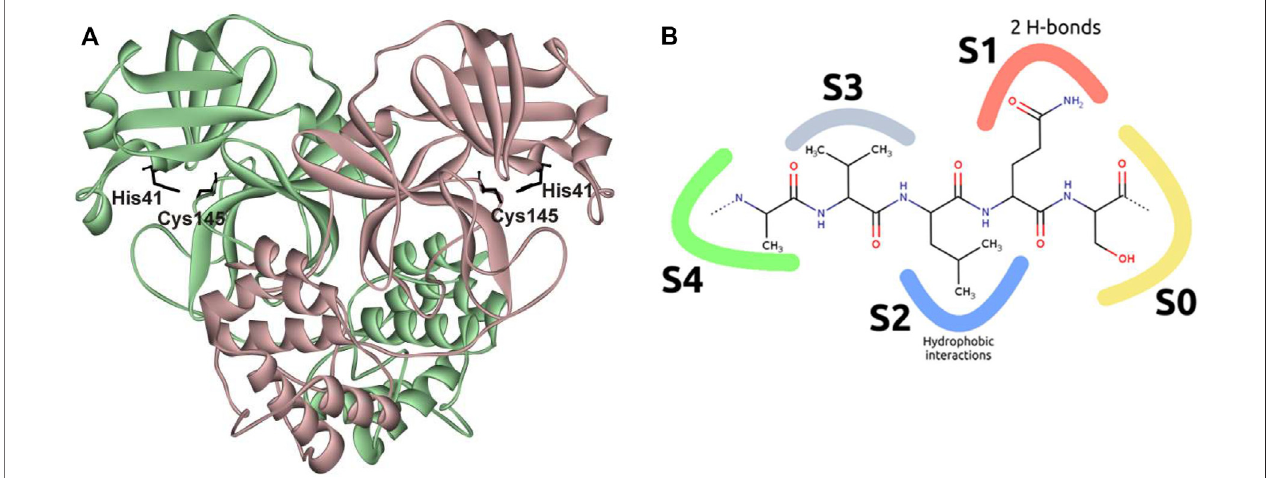
FIGURE1| StructureofSARS-CoV-2M pro . (A) OverviewofthestructureofanM pro complexwithPF-00835231(ProteinDataBank[PDB]ID6XHM(Hoffmanetal., 2020); ligand not shown); (B) schematic representation of interactions of the active site with the substrate. The S0 subpocket is formed mostly by Asn142, Ser144, Cys145,andLeu27;S1includesPhe140,His163,Glu166,andHis172;S2containsHis41,Met49,Arg188,andAsp187;S4includesGlu166,Leu167,Pro168,Gln189, and Ala191; and S3 is exposed on the outer surface of the active